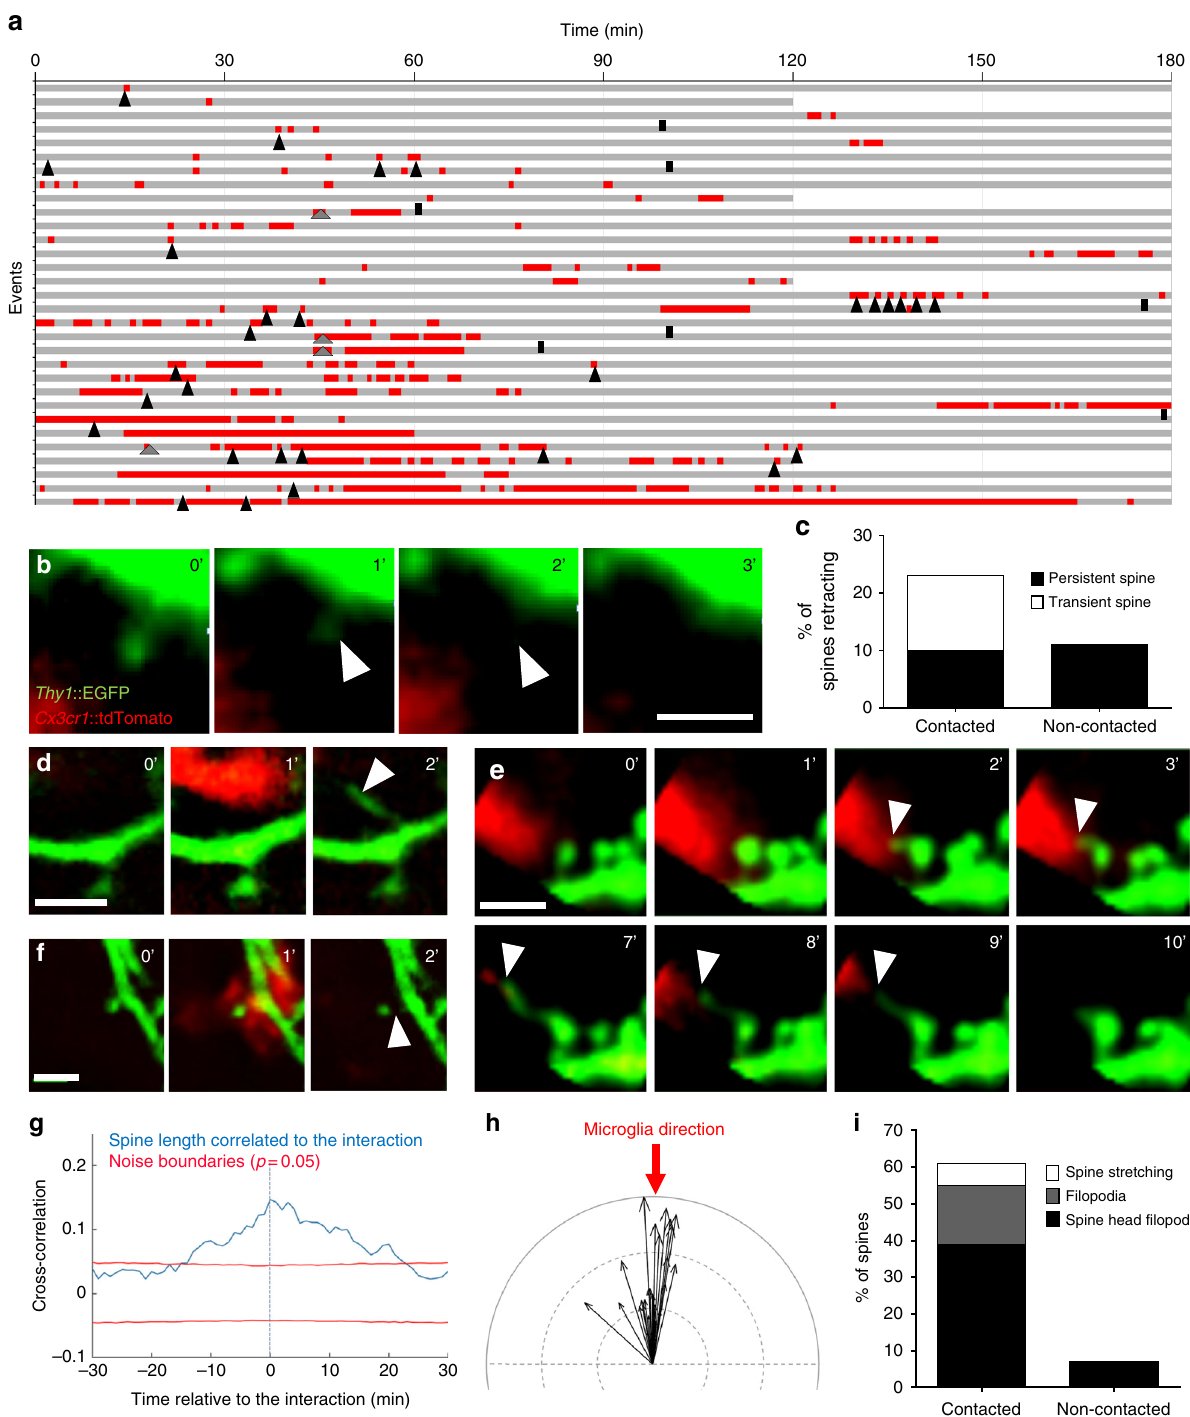
Fig. 6 Microglia induce spine head fi lopodia formation. a Quanti fi cation of microglia-spine contact duration (red) over the imaging session (gray). Each line represents a spine selected to have been contacted at least once by microglia and annotated for spine appearance (gray arrowhead), disappearance (black bar), and spine head fi lopodia formation (SHF, black arrowhead). Representative time sequence images of b spine disappearance, d fi lopodia formation, e SHF, and f spine stretching. c Quanti fi cation of spine retraction rate of contacted versus non-contacted neighboring spine. g Cross-correlation analysis revealed a signi fi cant increase in spine length during microglia-spine contact. h Vectorial analysis showed a signi fi cant correlation of microglial process direction (red arrow) with fi lopodia direction (Anderson – Darling test, P = 0.00047, n = 21 spine head fi lopodia analyzed, black arrows indicating fi lopodia length and direction, indentation = 1 µ m). i Quanti fi cation of spine stretching, fi lopodia formation, and spine head fi lopodia formation events in contacted versus non-contacted neighboring spines ( n = 31 and 28, respectively, from 4 organotypic slice cultures). Scale bars: 2 µ